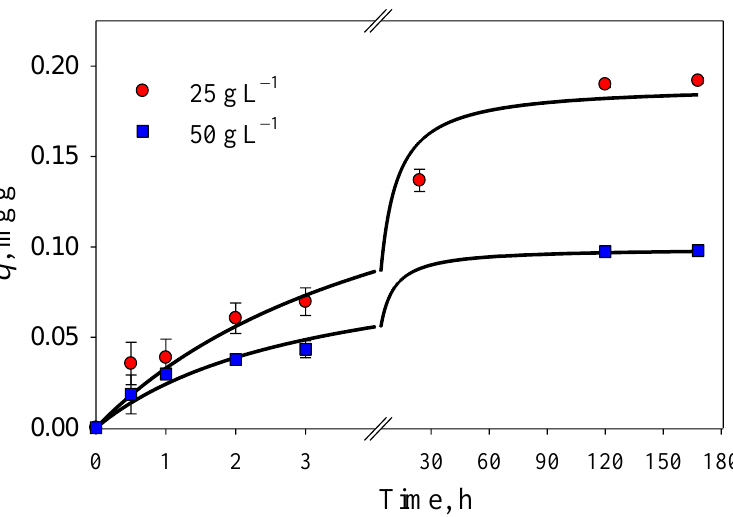
Figure 6. Adsorption kinetics of As(V) on the clay. Conditions: [As(V)] = 5 mg L − 1 , pH 7, [clay] = 25 or 50 g L − 1 , RT, EC = 0.03 mS cm − 1 . Error bars represent the standard deviation between duplicates, while the full line is the adjustment to Equation (6).